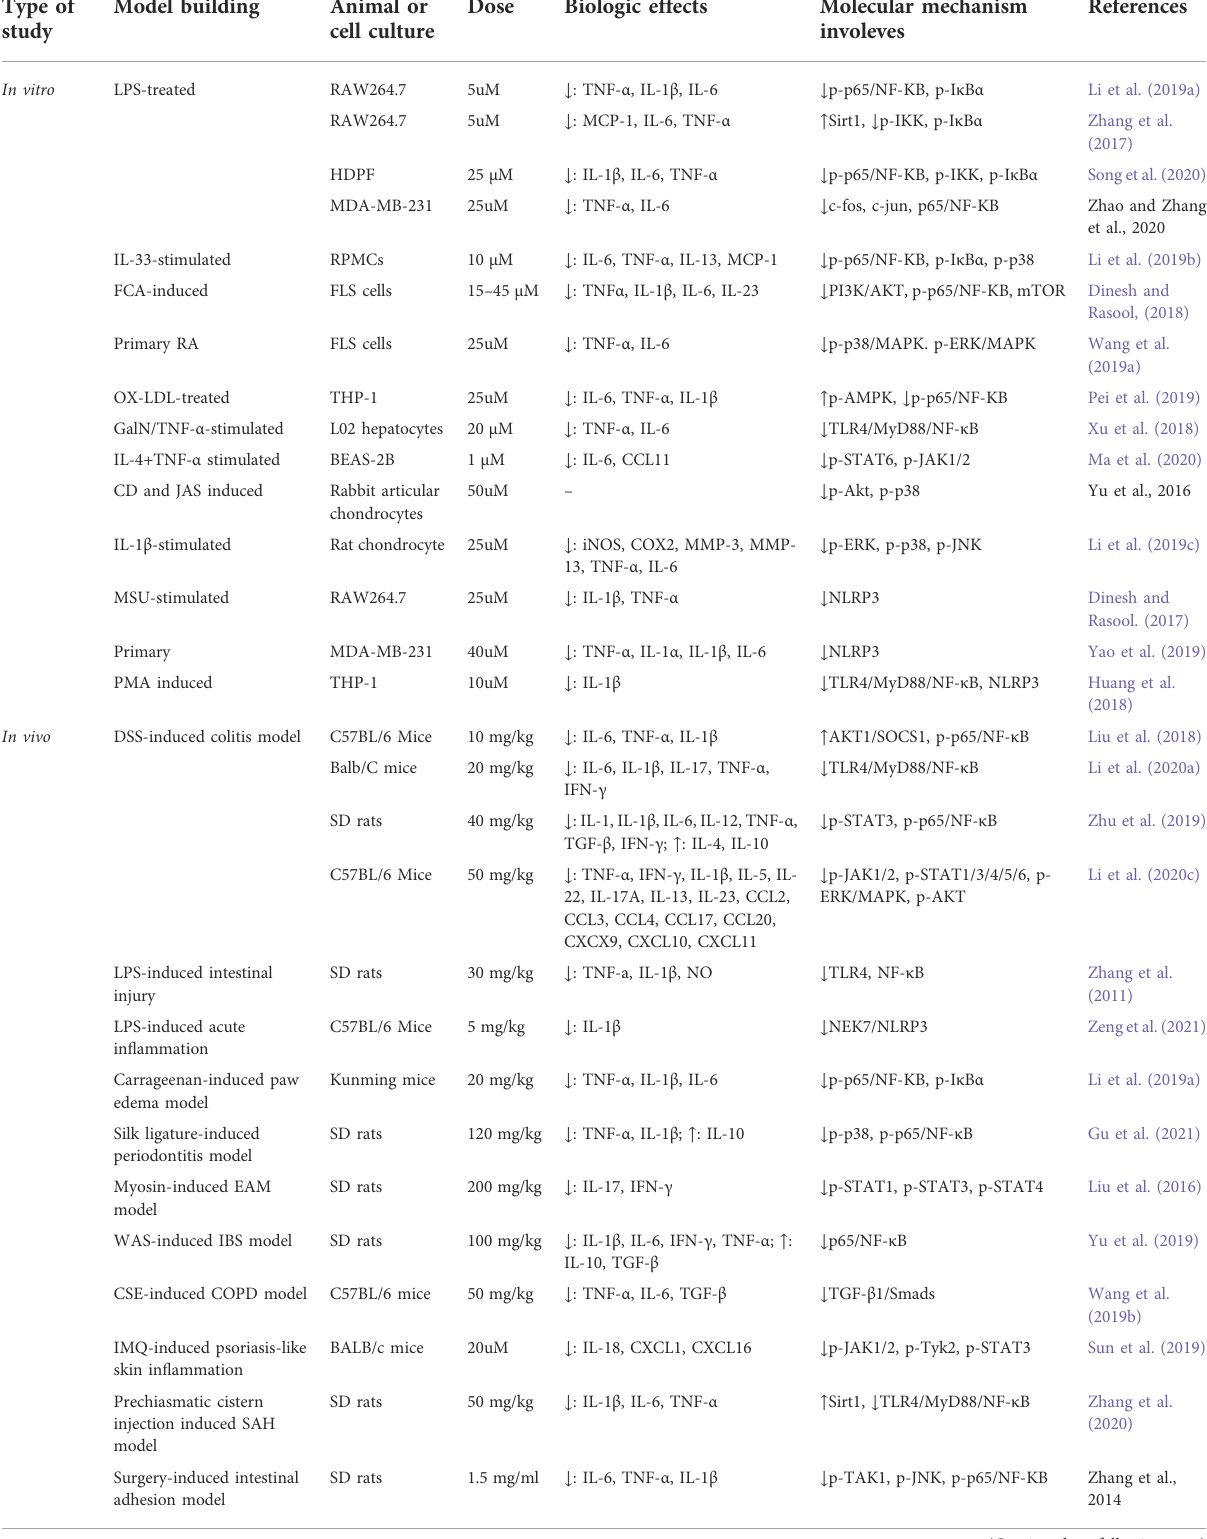
TABLE 1 The reported anti-in fl ammatory inhibition of